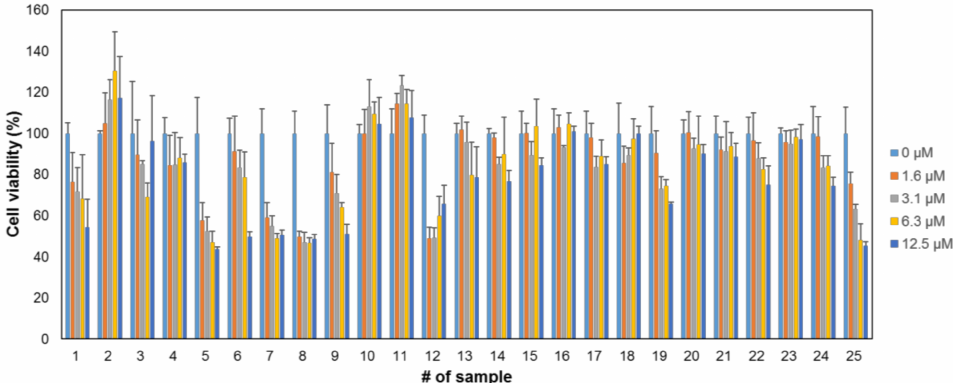
Figure 1. Cytotoxicity of novel synthetic compounds. B16F10 murine melanoma cells were treated with each compound at various concentrations (0, 1.6, 3.1, 6.3, and 12.5 µ M) for 24 h. CCK-8 assay was performed to assess the cytotoxic effect. n = 3; error bars, mean ±